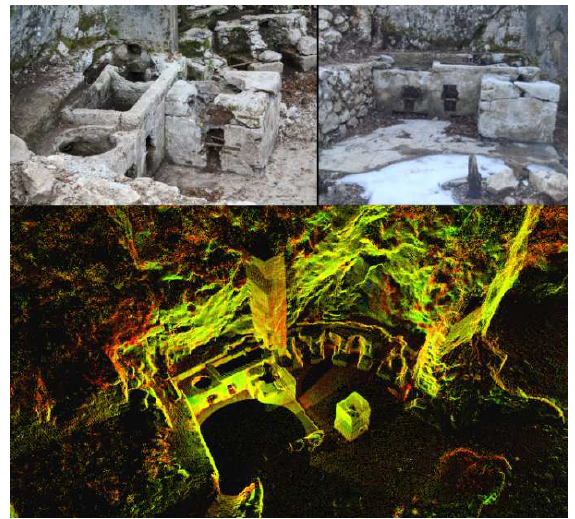
Figure 8. Detail of the field kitchens: present state (top) and visualization of the 3D point cloud